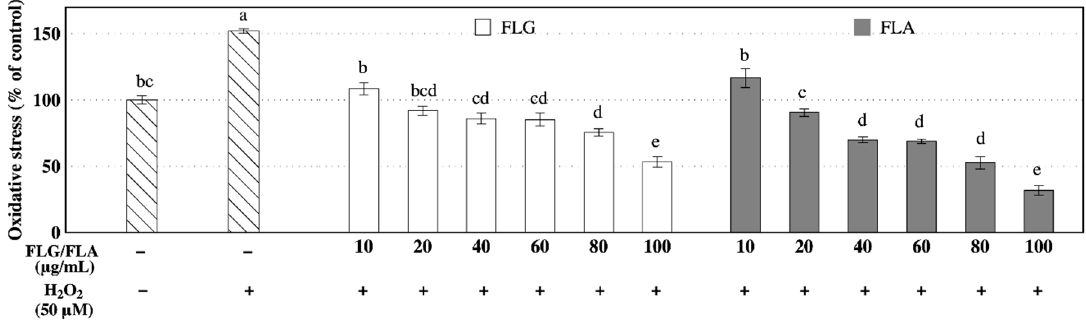
Figure 3. Effects of the fractions rich in flavonol glycosides (FLG) and flavonol aglycones (FLA) on intracellular oxidative stress in neuron-like PC-12 cells. Lowercase letters on the bars indicate significant differences according to the Tukey–Kramer HSD test ( p < 0.05).